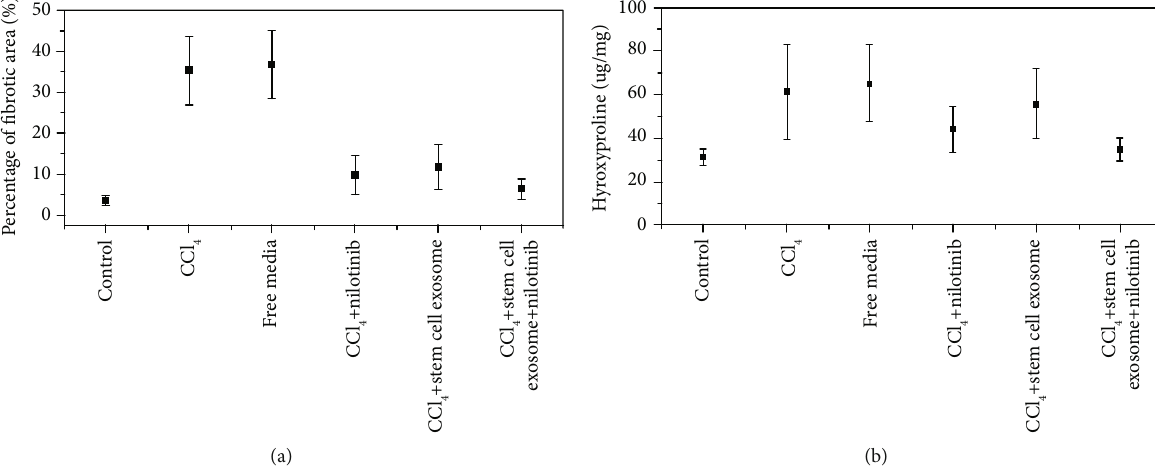
Figure 3: (a) Percentage of fi brotic area among the studied groups. (b) Hydroxyproline content among the studied